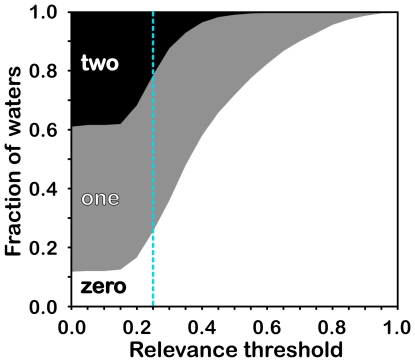
Selection of Relevance threshold.Fraction of waters Relevant to neither (white), one (gray) and both (black) proteins. Relevance was previously trained [50] so that waters having total values 0.50 or greater with respect to all other molecules are conserved; 0.25 (blue line) is the corresponding Relevance with respect to one molecule (protein). Values less than 0.25 are thus not statistically meaningful, while the rapid decrease in the number of bridging waters for thresholds between 0.15 and 0.40 argues for a low threshold. Thus, the selected 0.25 threshold meets both criteria.